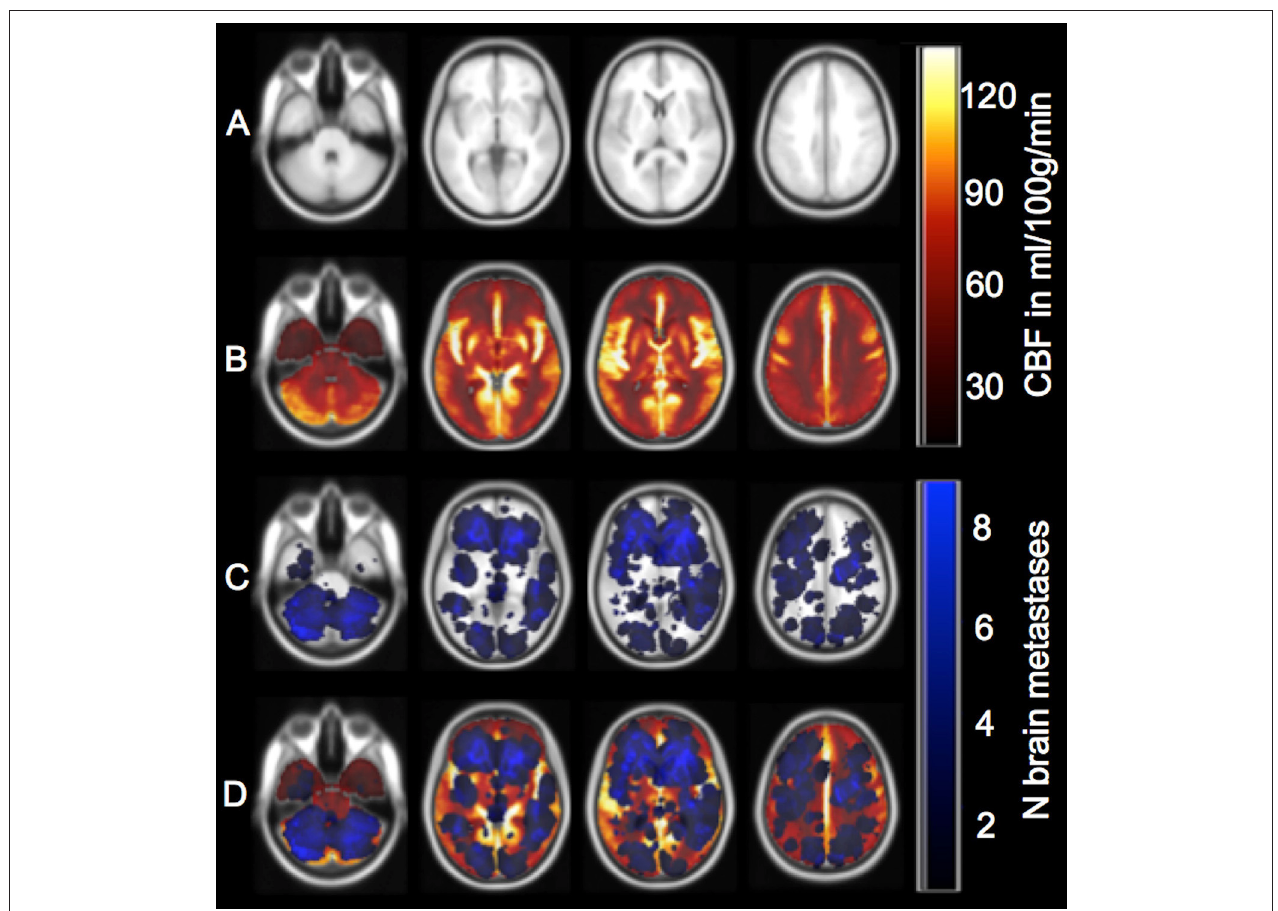
FIGURE 1 | Overview of perfusion calculation from caudal to cranial (1–4). (A) Example of the 1mm MNI brain that served as a template for co-registration of the patient’s contrast-enhanced T1-weighted images and the CT perfusion map. (B) Display of the cerebral blood flow (CBF) map (see color scale on the upper right; light yellow also corresponds to CBF values ≥ 120 ml/100 g/min due to better visualization). Cerebral blood volume (CBV), mean transit time (MTT), and time to peak (TTP) maps are not depicted. (C) Cumulative brain metastases frequency map (see color scale on the lower right; light blue also corresponds to ≥ 8 brain metastases due to better visualization). (D) Overlay of the metastases sum map, the perfusion map, and the MNI brain. CBF, CBV, MTT, and TTP values were extracted for each voxel-group with and without a